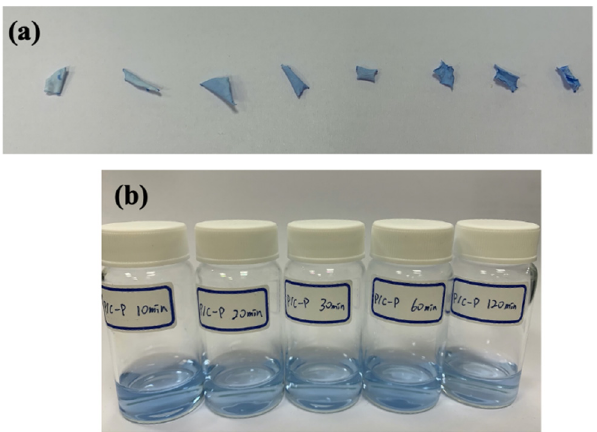
Figure A1. Sorption of 100 ppm copper(II) sulfate pentahydrate onto PEI-CS/PCL_60s membranes. Color changes of ( a ) PEI-CS/PCL and ( b ) copper-contained solution with increasing immersion time.